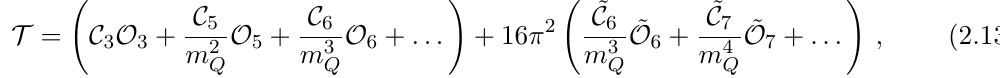
The right-hand side of (2.10) can then be expanded, using the HQE, in powers of Λ and α , where m is the heavy-quark mass and Λ /m s Q Q QCD